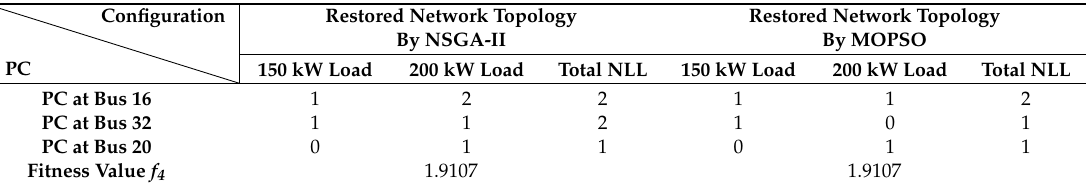
Table 7. Total number of Non-Linear Loads (NLL) connected to the radial path of the priority customer buses in the plan obtained through Non-Dominated Sorting Genetic Algorithm-II (NSGA-II) and Multi-Objective Particle Swarm Optimization (MOPSO).